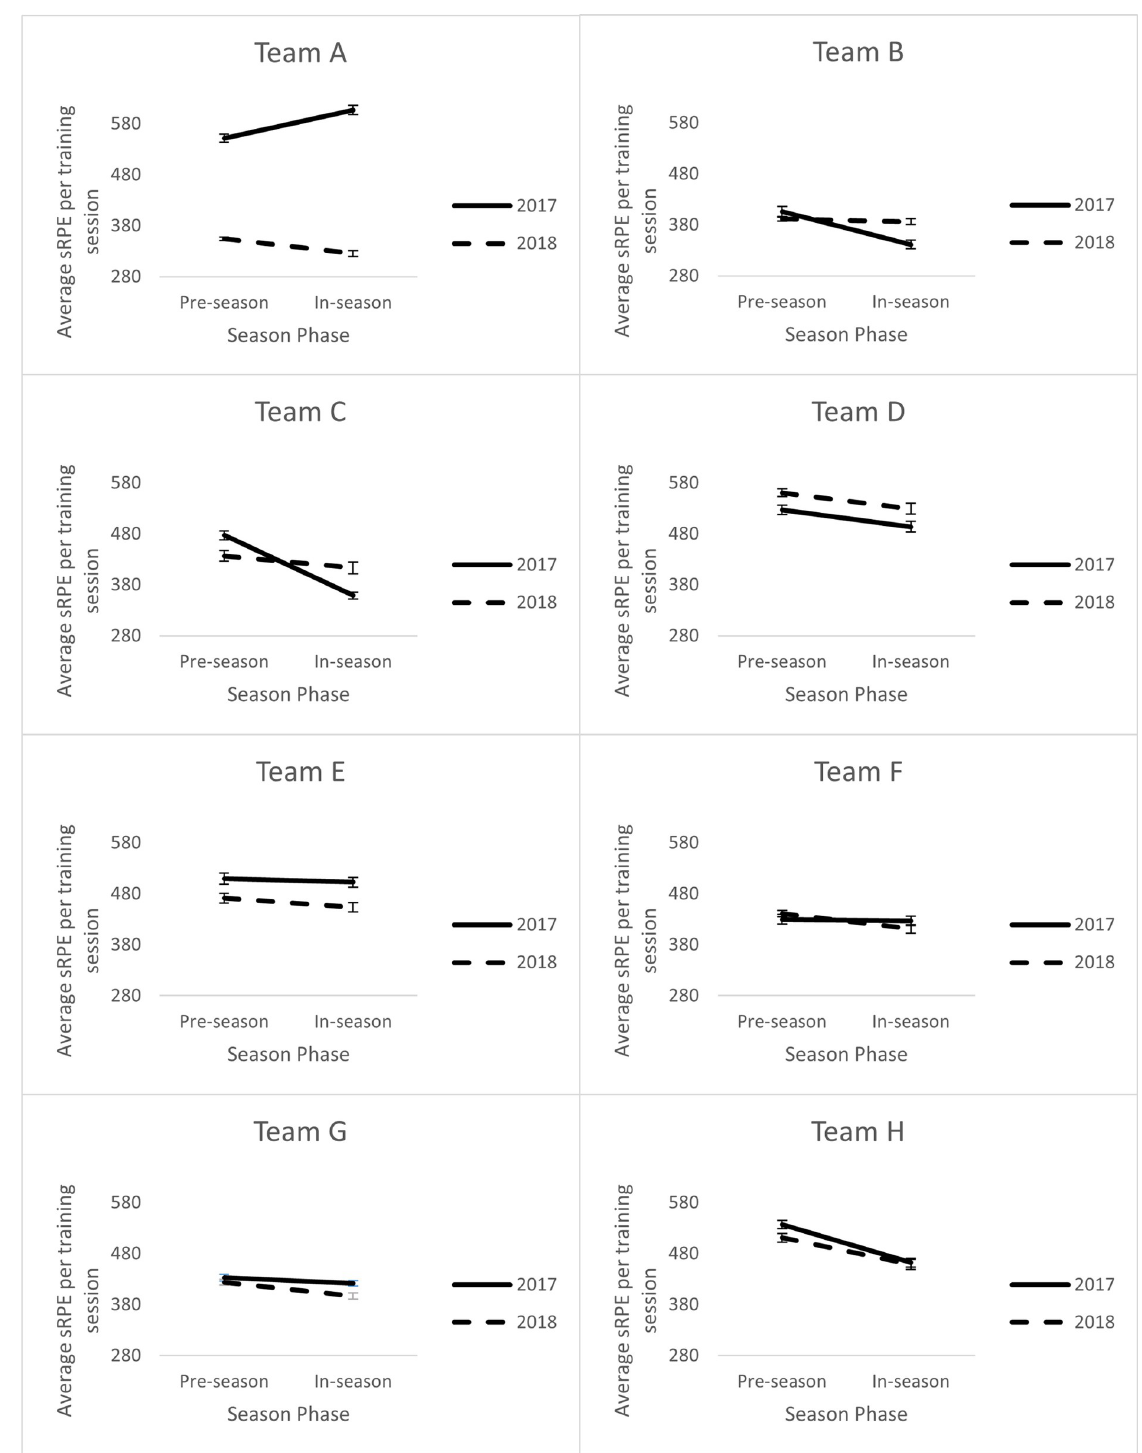
Fig 3. Year by season phase interaction for all